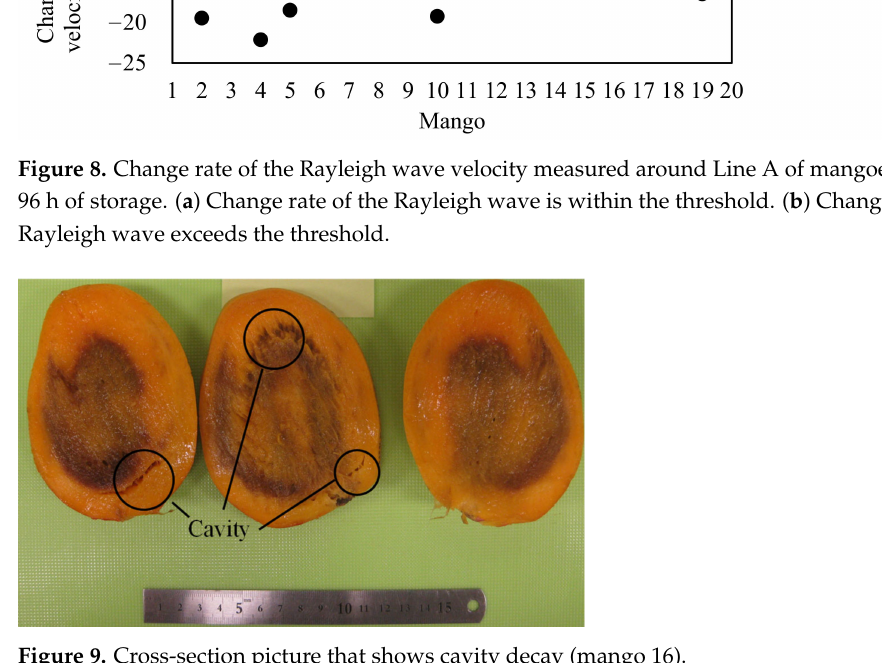
Figure 9. Cross-section picture that shows cavity decay (mango